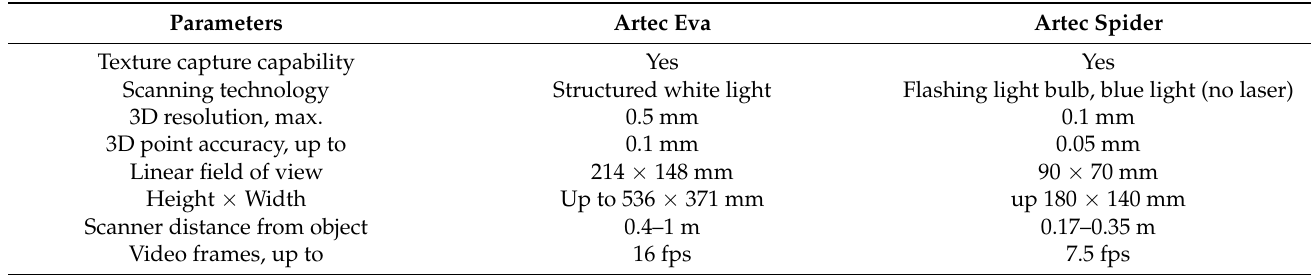
Table 1. Comparison of the basic parameters of scanners Artec Eva and Artec